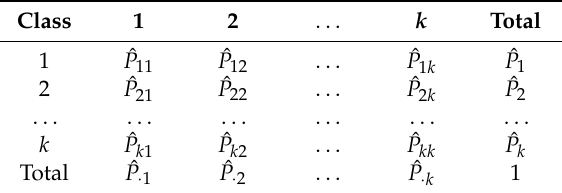
Table 4. Error matrix of estimated area proportions, ˆ P ij (Equation